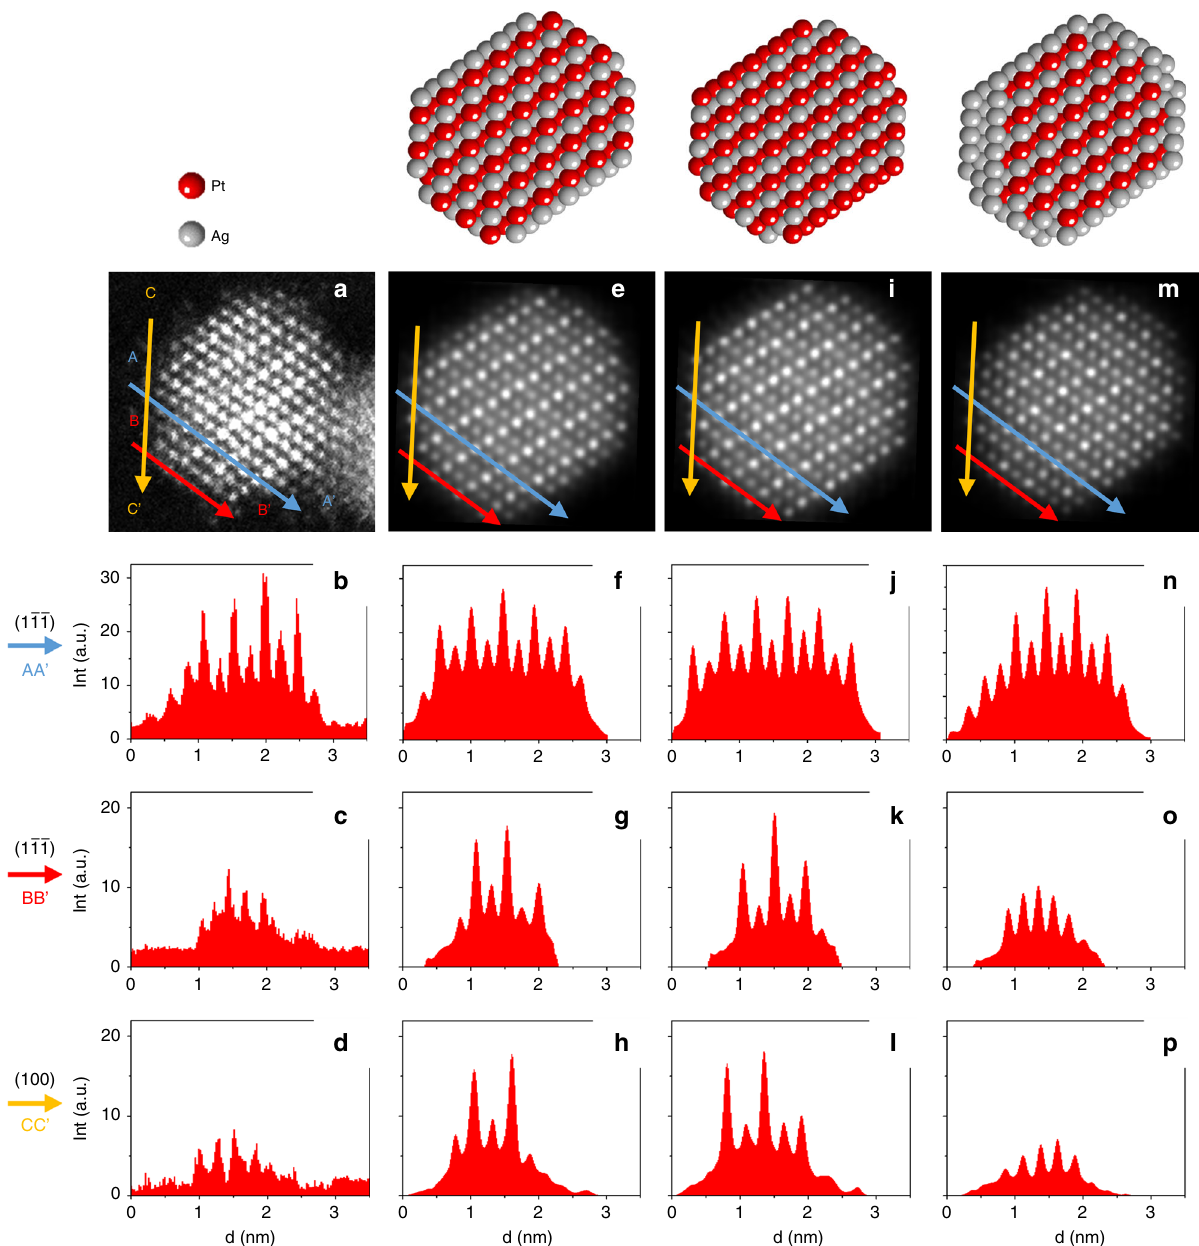
Fig. 3 L1 1 @Ag-skin nanoparticle. a – d High-resolution STEM-HAADF image of a 2.8 nm NP in the [01 (cid:1) 1] zone axis with its corresponding intensity pro fi le lines. e – h , i – l and m – p show the model 1, 2, and 3 in the [01 (cid:1) 1] zone axis, respectively, with their corresponding intensity pro fi le lines. The intensity pro fi les were done for three different locations: along the (1 (cid:1) 1 (cid:1) 1) plane close to the centre of the NP (AA ′ ), along the (1 (cid:1) 1 (cid:1) 1) plane at the NP surface (BB ′ ) and along the (100) plane at the NP surface (CC ′ ). STEM-HAADF high angle annular dark fi eld in scanning transmission electron microscope, NP (cid:1) (cid:1) (cid:1) [01 1] columns. Close to the NP centre and parallel to the (1 1 1) planes, the intensity variation (Fig. 3b, AA ′ pro fi le line) shows the alternation between bright Pt and darker Ag planes. At both line extremities (A and A ′ ), the intensities correspond to a minimum which can be explained if the atomic columns at the NP surface are pure Ag. Comparison with the simulated pro fi les indicates that model 2 can be excluded (Fig. 3b, j). To discriminate between (cid:1) (cid:1) models 1 and 3, surface pro fi le lines on the {1 1 1} and {100} facets (B to B ′ and C to C ′ lines, respectively) were collected. Model 1 shows alternating contrasts for both facets (Fig. 3g, h) contrary to model 3 (Fig. 3o, p) and to the experimental pro fi les (Fig. 3c, (cid:1) (cid:1) d), indicating that (1 1 1) and (100) surface planes are pure Ag.